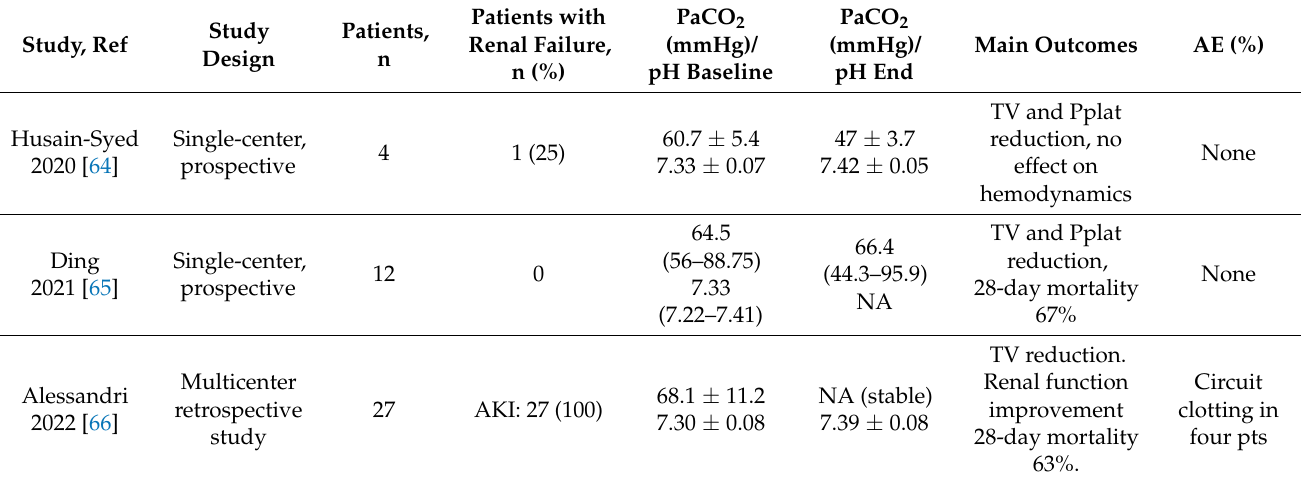
Table 3. Design, patient characteristics, and outcome of studies reporting use of combined ECCO 2 R– CRRT treatment in COVID-19 patients with